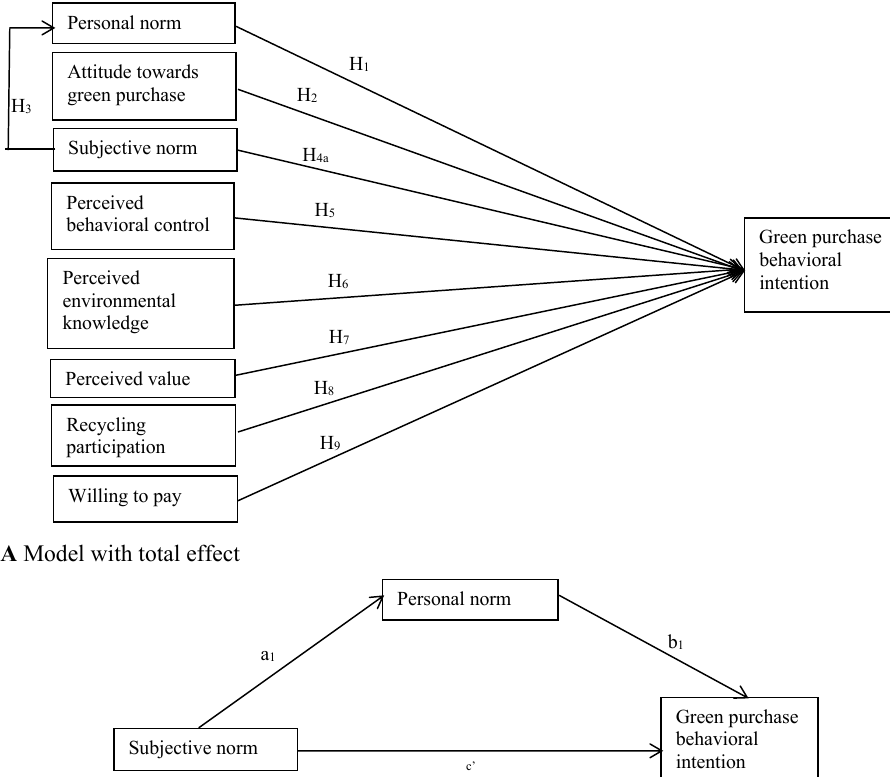
Figure 1. Research framework.